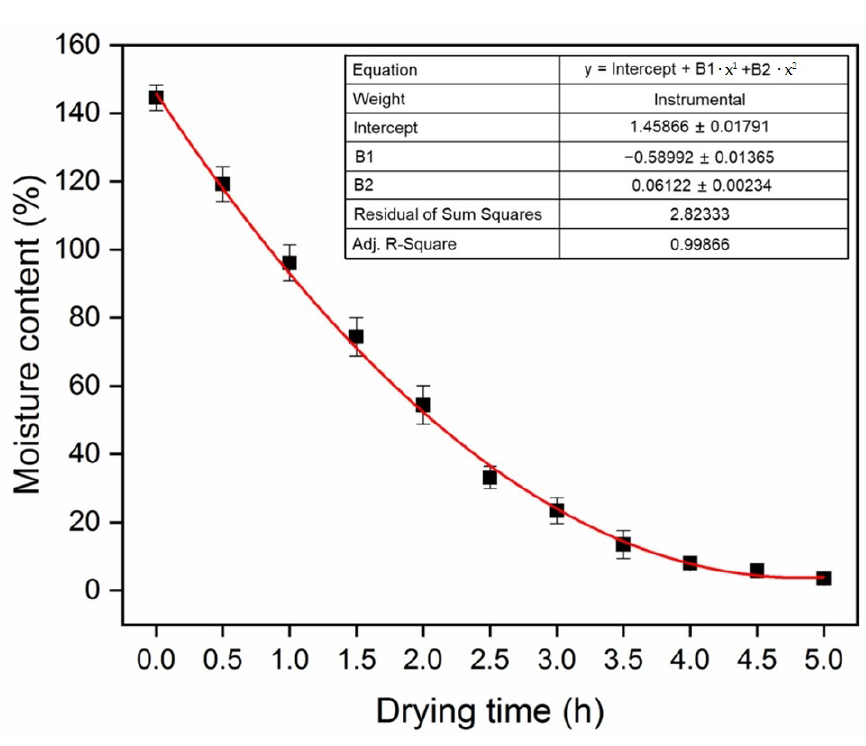
Figure 2. The fitting curve of MC as a function of drying time.